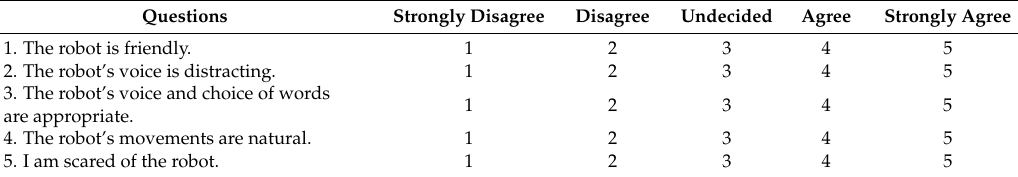
Table A5. Interim-survey section 2/3.